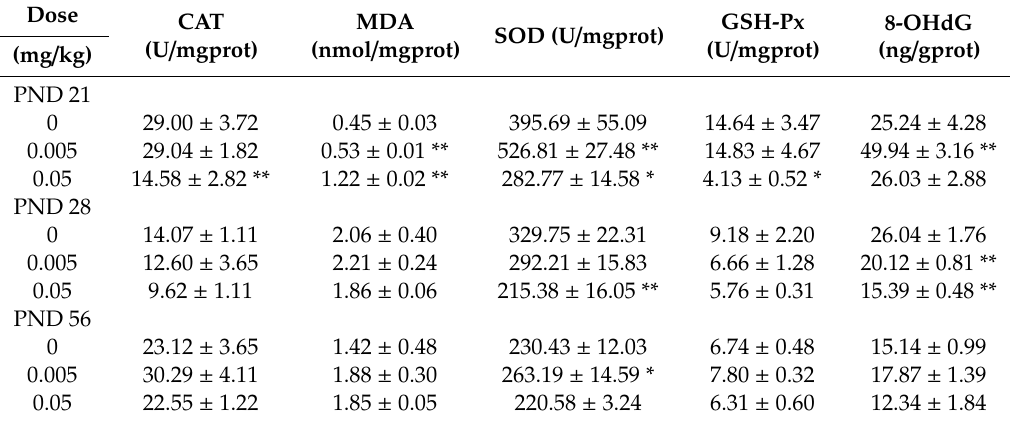
Figure 2. E ff ects of maternal exposure to T-2 toxin on the testicular histology of o ff spring. Figure 2. Effects of maternal exposure to T-2 toxin on the testicular histology of offspring. ( A ) Representative ( A ) Representative images of testicular histology, sections were stained with hematoxylin-eosin images of testicular histology, sections were stained with hematoxylin-eosin (magnification: ×400). ( B ) The (magnification: × 400). ( B ) The cross-sectional area of seminiferous tubules. ( C ) The height of cross-sectional area of seminiferous tubules. ( C ) The height of seminiferous epithelium. Each value represents seminiferous epithelium. Each value represents the mean ± SEM of the group ( n = 3). * p < 0.05: the mean ± SEM of the group ( n = 3). * p < 0.05: compared with the control (0 mg/kg T-2 toxin). compared with the control (0 mg / kg T-2 toxin). Table 3. E ff ects of maternal exposure to T-2 toxin on the capacity of antioxidant system and DNA damage in the testes of o ff